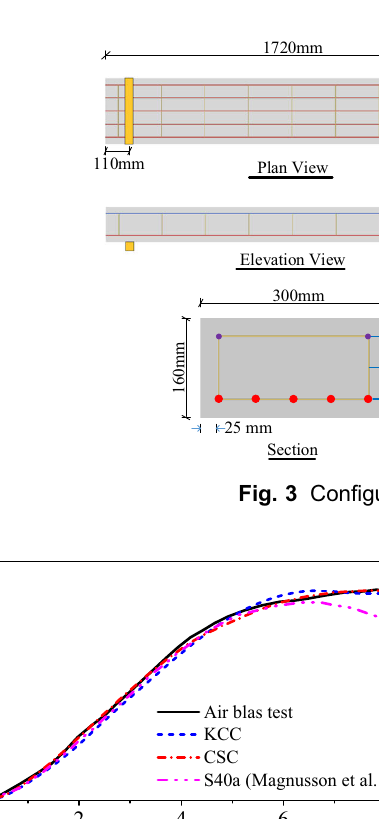
Fig. 2 Comparison of the mid-height deflection a mid-height displacement time history, b deformation state at t = 200 ms.